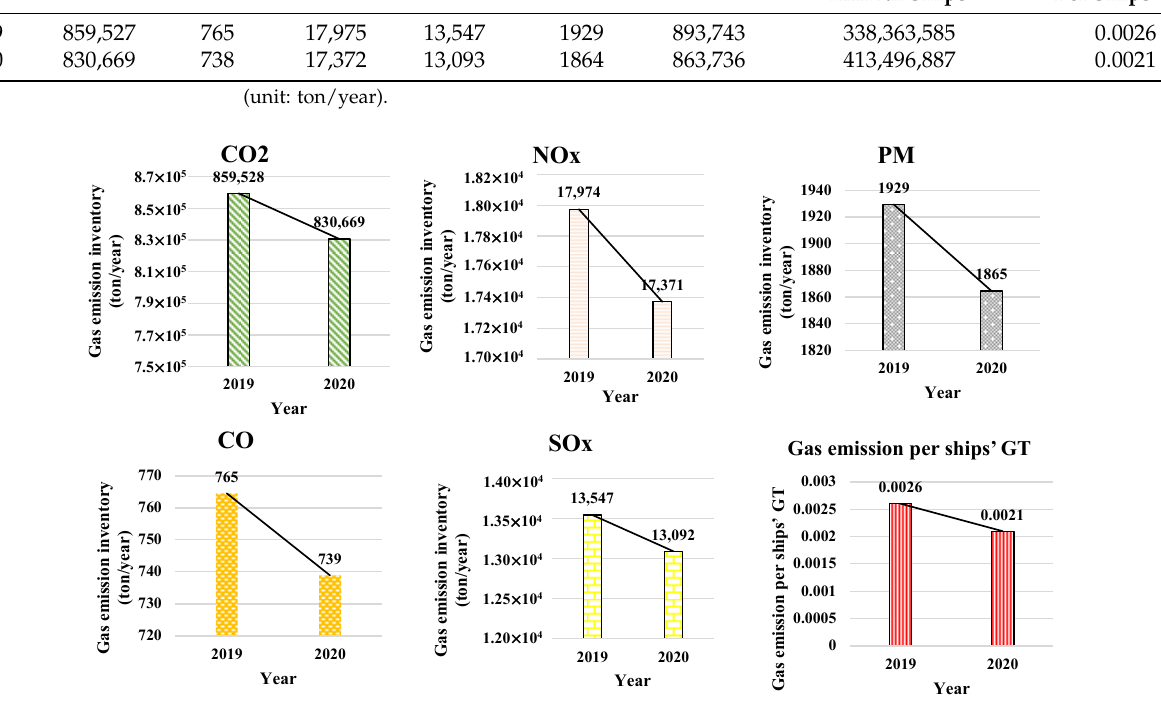
Figure 7. Gas emission inventory and gas emission per ships’ GT in 2019 and 2020.